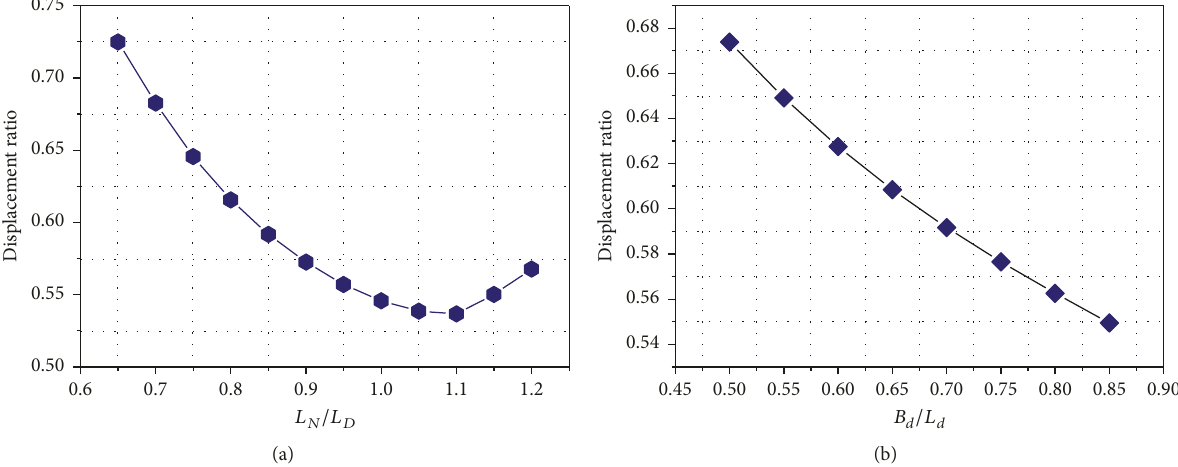
Figure 13: Relation schema of displacement ratio between controlled structure and uncontrolled